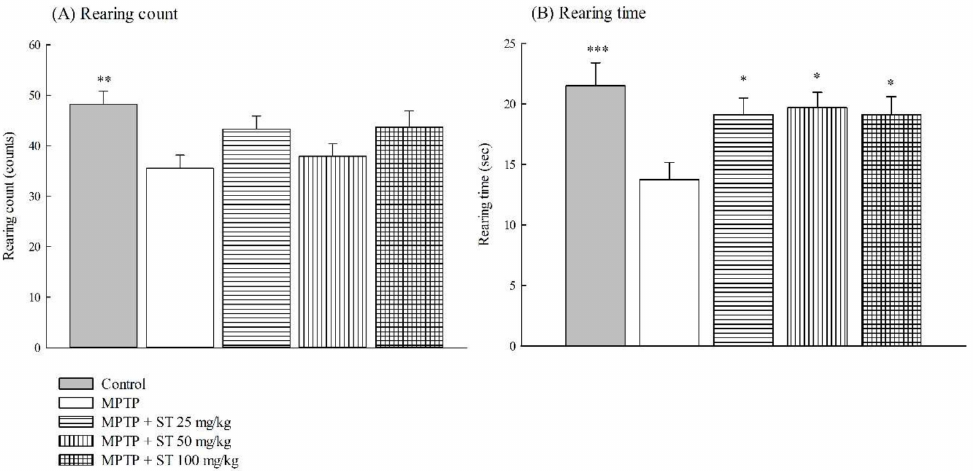
Figure 2. Effect of Sophora tomentosa extract (25 mg/kg, 50 mg/kg, and 100 mg/kg, po) on (A) rearing count and (B) rearing time on an open field test in an MPTP-induced PD mouse model. Data